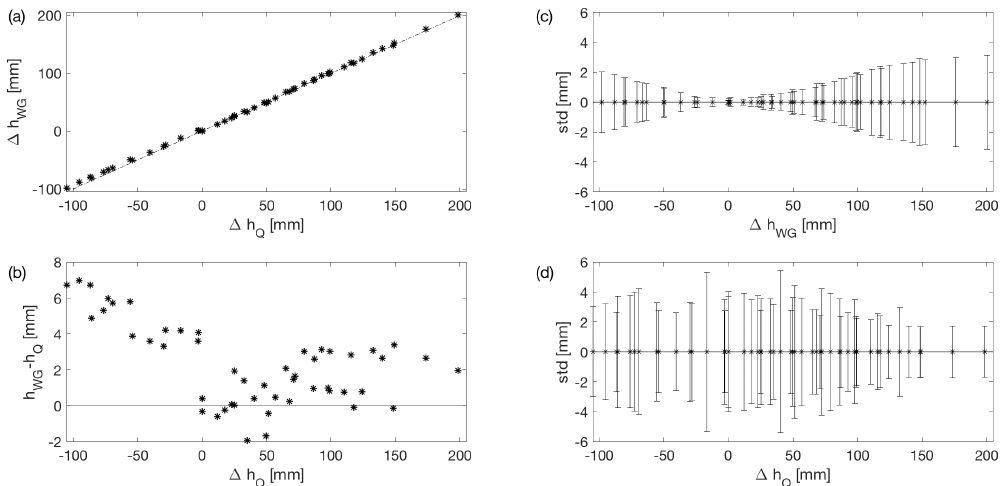
Figure 3. Comparison of the methods with a variable water depth h inside the cylinder—( a ) comparison between water depth captured with the marker balls via Qualisys (Q) and wave gauges (WG); ( b ) absolute differences between the methods; ( c , d ) standard deviation (std) for each